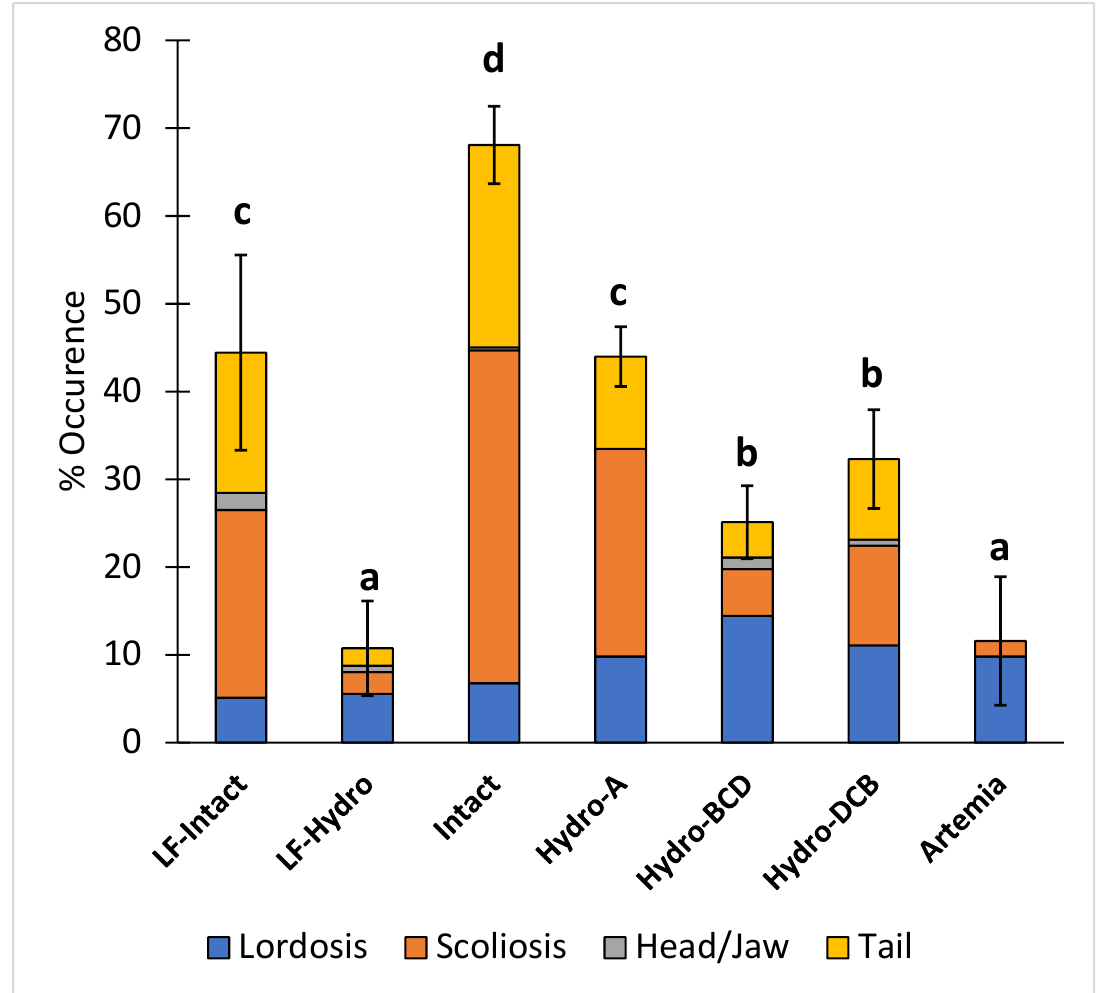
Figure 6. Diet effect on the occurrence of skeletal deformities (Lordosis, scoliosis, and head/jaw and tail deformities). Values are presented as means and error bars represent standard deviation for total deformities. Letters indicate statistical significance between groups. The significance was determined using a One-Way ANOVA and a Tukey test with a p value < 0.05.